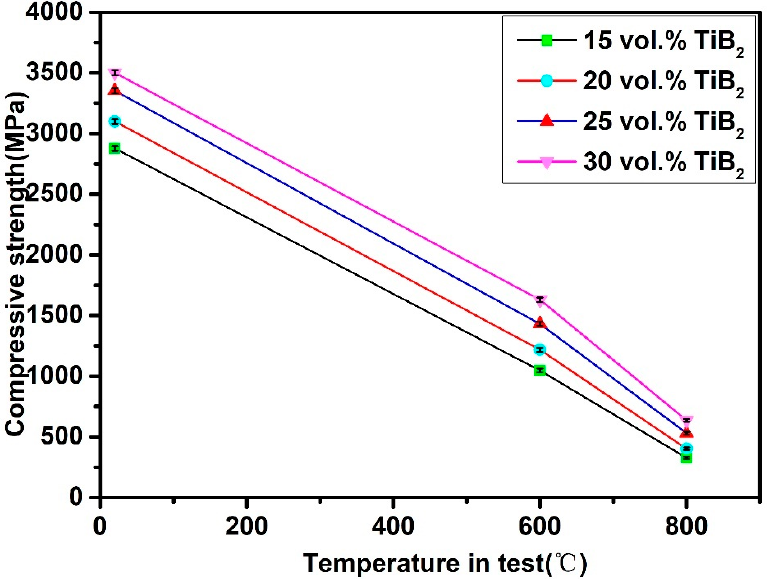
10 of 13 Figure 10. Compressive stress-strain curves obtained for TiB 2 /Fe-15Cr-10Mn-5Al composites with different TiB 2 at: ( a ) room temperature, ( b ) 600 °C, ( c ) 800 °C. Figure 11 illustrates the strength values (in compression tests), which were plotted based on the temperature. Applied temperature has leaded to a gradual reduction of the